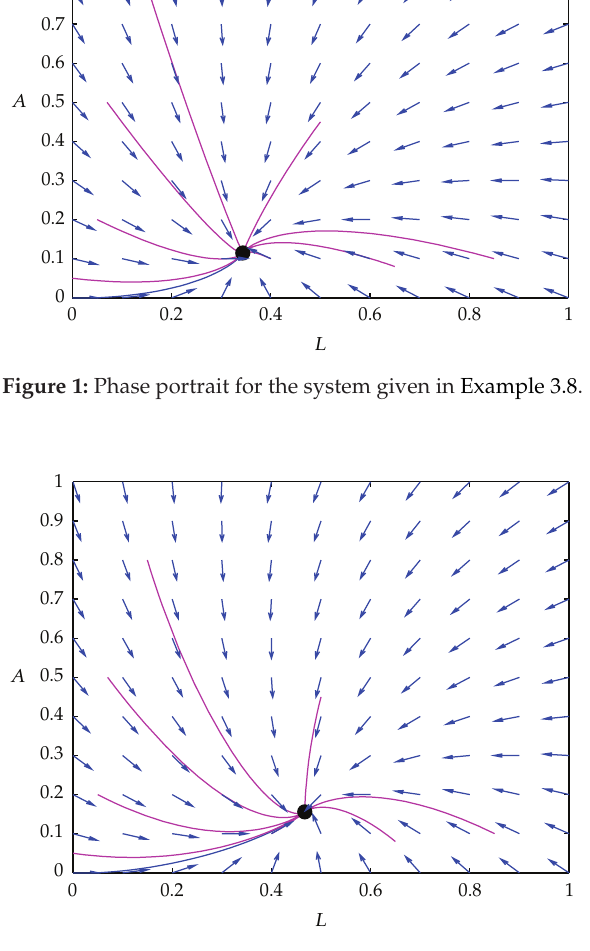
Figure 2: Phase portrait for the system given in Example